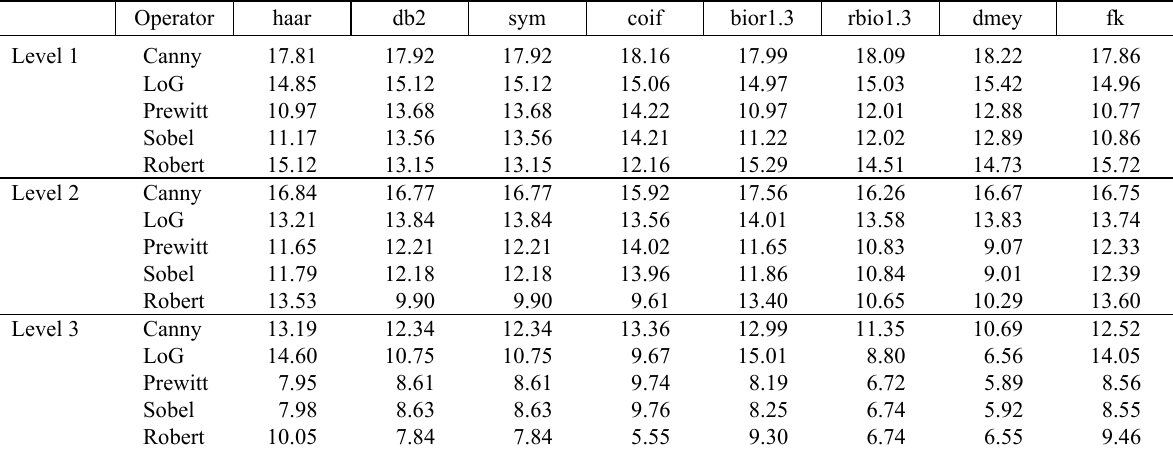
Table 6. PR values for different edge detection operators and wavelet transformations for an image with MD Operator